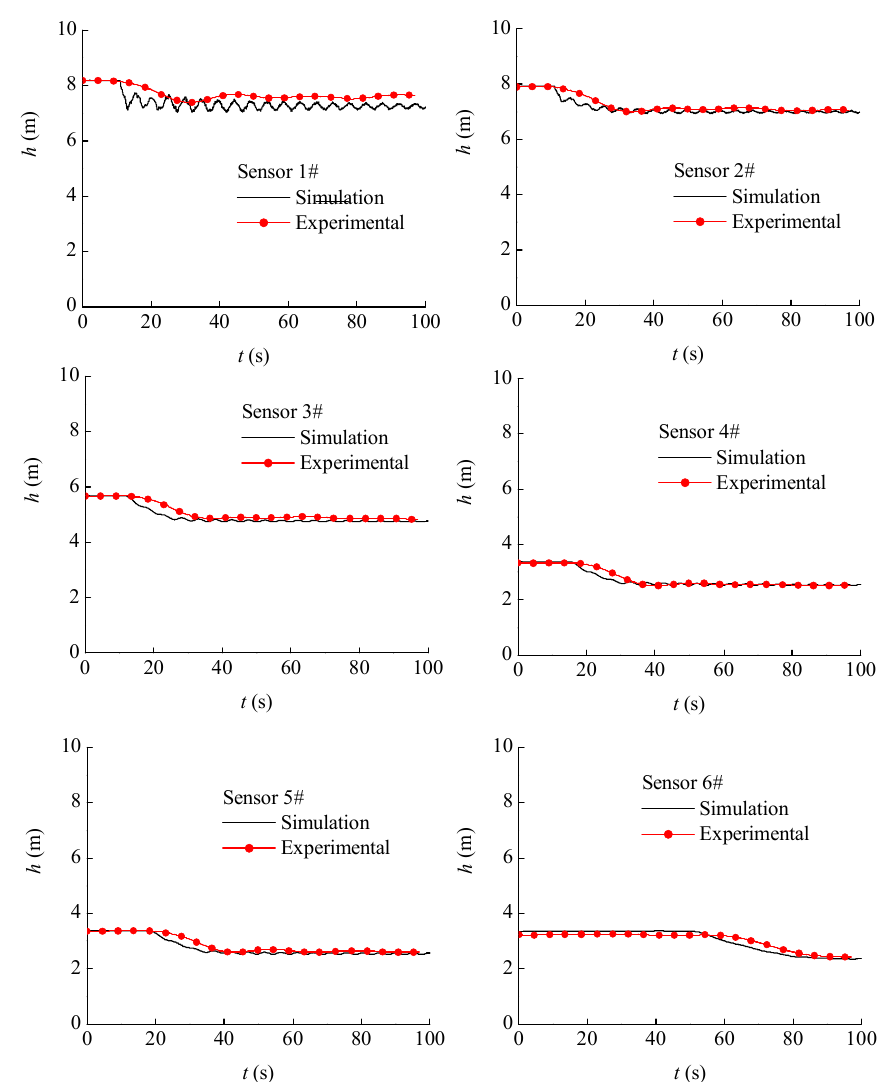
Figure 17. Comparison between the simulation and the experiment on a transient process.